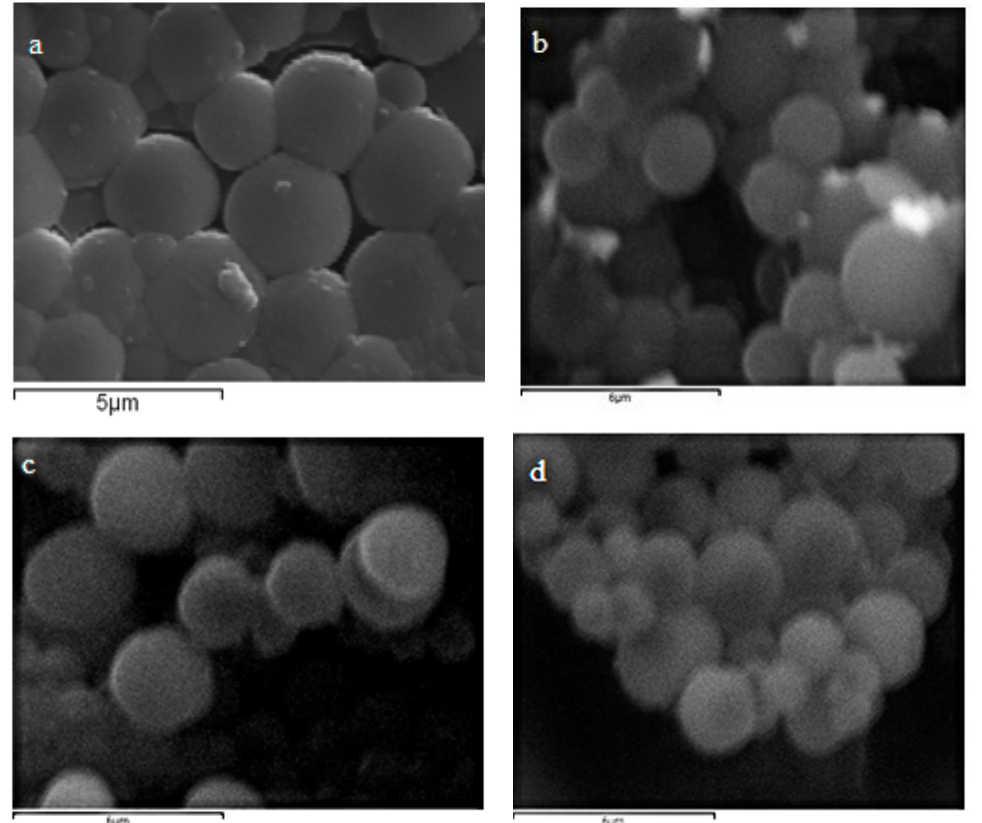
Figure 2. SEM pictures of ( a ) net PLLA microparticles, ( b ) PLLA-DSU 5% w / w microparticles, ( c ) PLLA-DSU 10% w / w microparticles, ( d ) PLLA-DSU 20% w / w microparticles.